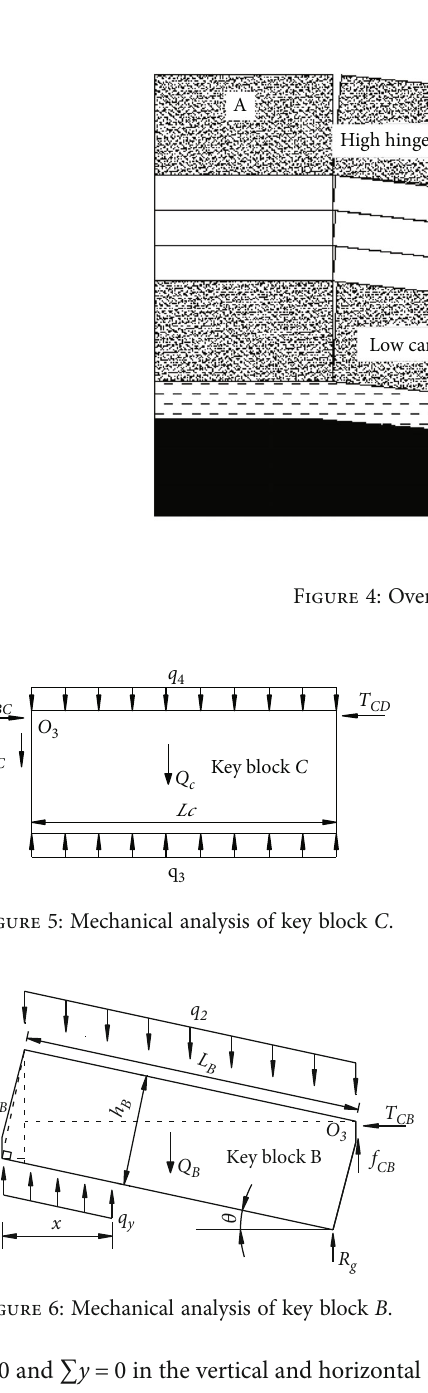
Figure 8: Numeric calculation